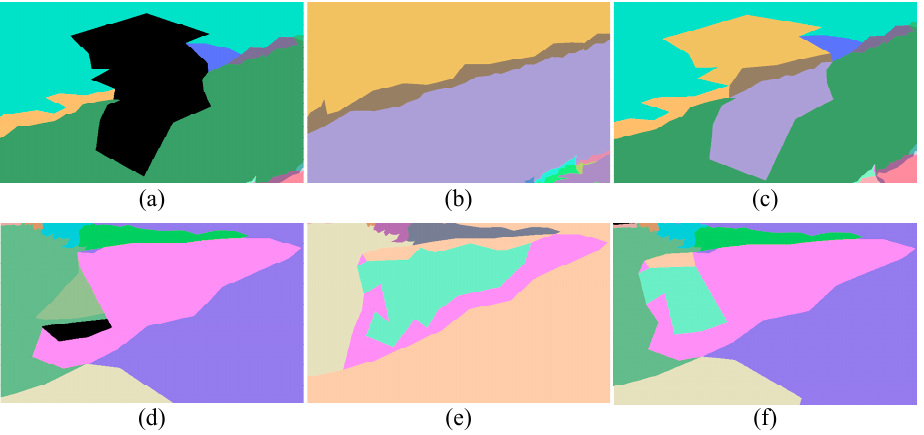
Figure 8. The planar proxies before and after hole filling: (a) and (d) show the planar proxies of the Pixiu model and WCGC-S model before hole filling; (b) and (e) are them after hole filling, and in (a), (b), (d), and (e), different colors represent different planar proxies; and (c) and (f) indicate the contrast the planar proxies between before and after hole filling.